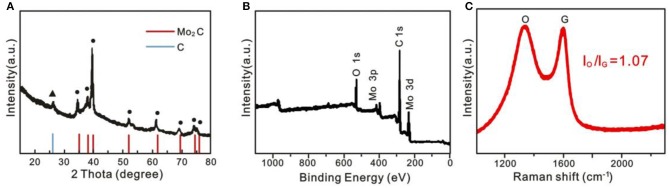
(A) XRD pattern, (B) XPS survey spectra, and (C) Raman spectra of hollow porous Mo2C@C nanoballs.